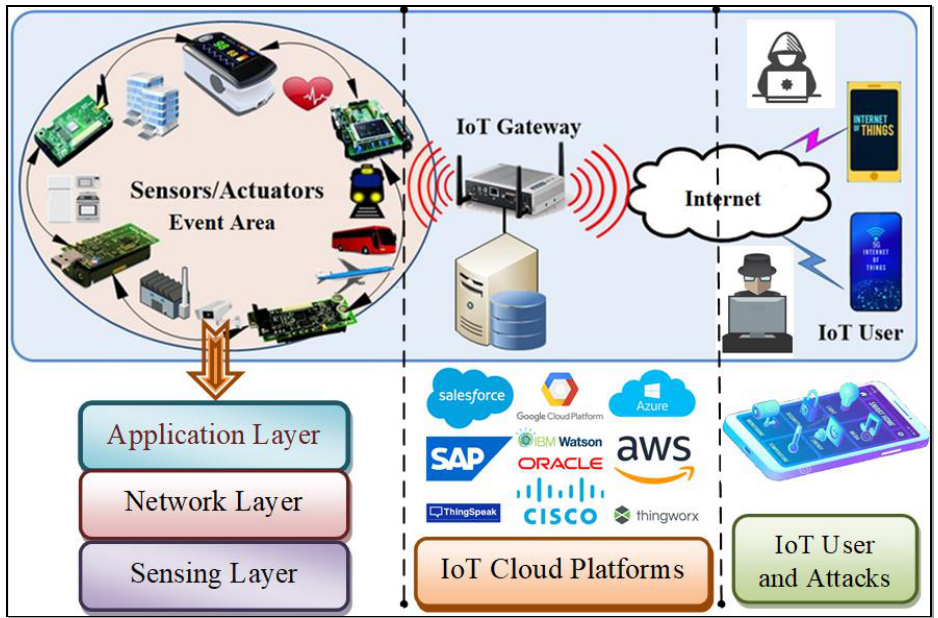
Figure 1. IoT general architecture.